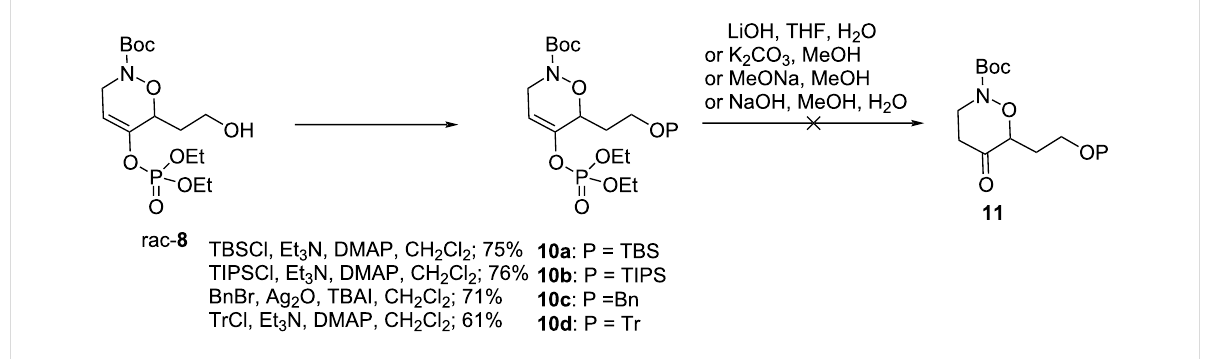
Scheme 3: Attempts for hydrolysis of the enol phosphate under basic conditions.